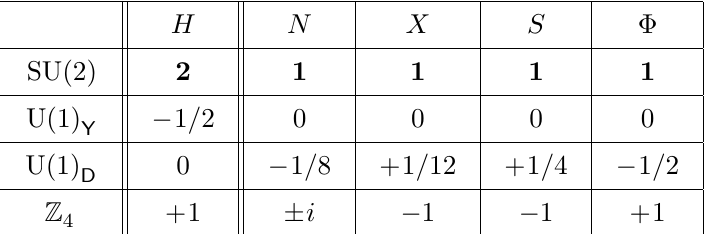
Table 1 . Charge assignments of the fermion and scalars in the r SIMP model, where H is the SM √ Higgs doublet and i = − 1